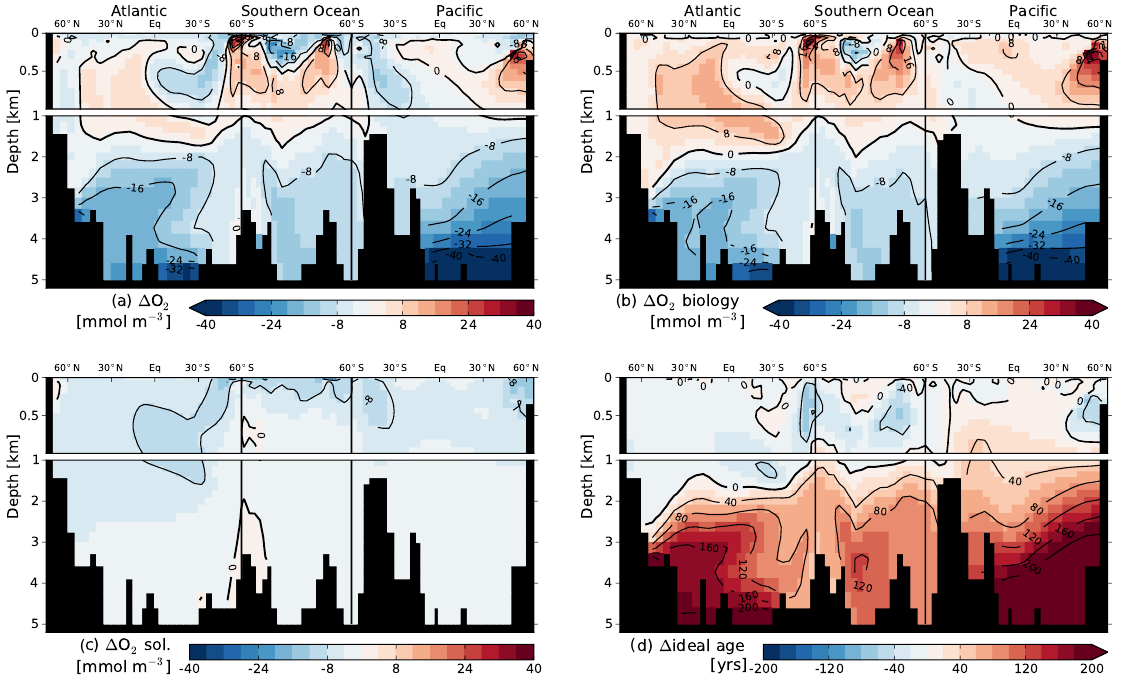
Figure 3. Changes in O 2 and its components at time of peak O 2 decline (AD3150) relative to preindustrial steady state for a single repre- sentative ensemble member reaching the 1.5 ◦ C warming target. (a) Change in total O 2 , (b) change in O 2 due to biology, (c) change in O 2 due to solubility, (d) change in ideal